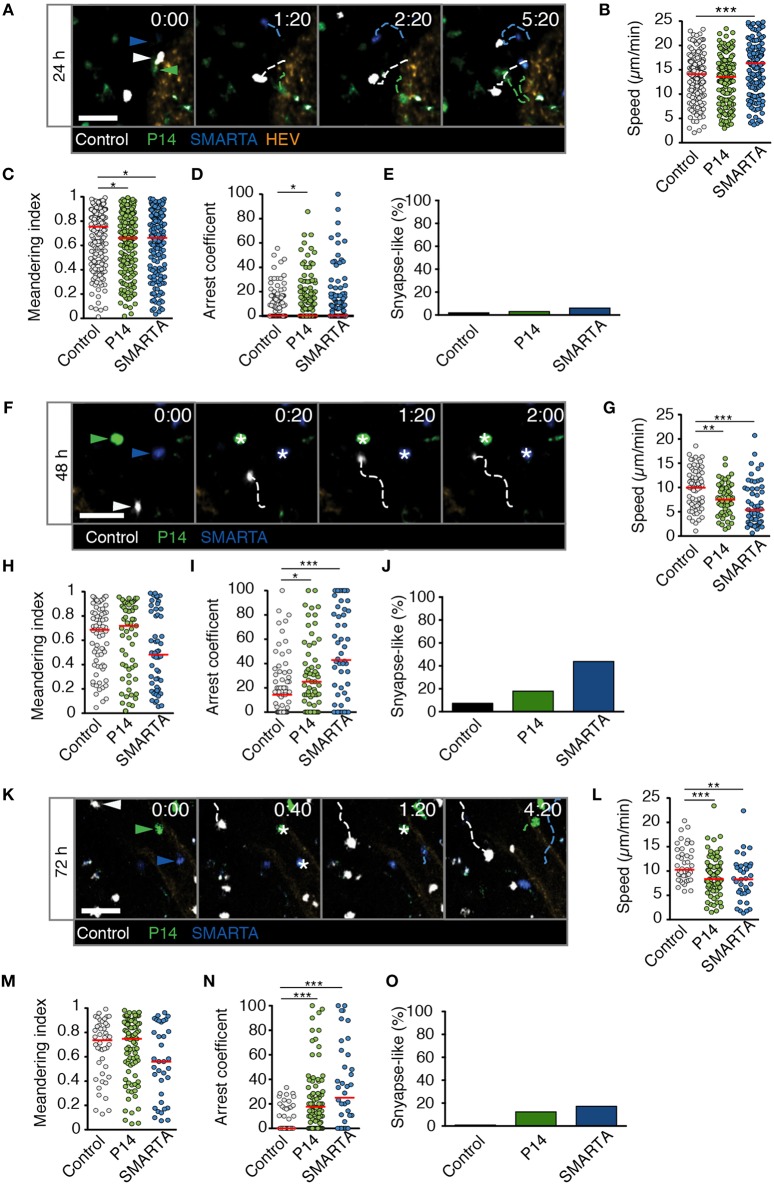
T cell motility in reactive LNs during LD LCMV infection. (A) Representative 2PM images of control (white), P14 (green), and SMARTA T cell tracks (blue) with HEV (orange) at 24 h p.i. Arrowheads point the tracked cell: control (white), P14 (green), and SMARTA (blue). Scale bar, 20 μm. (B–E) Quantification of 2PM motility parameters at 24 h p.i.: Migration speed (B), Meandering index (C), arrest coefficient (D), and percentage of synapse-like T cell motility (E) of control (gray), P14 (green), and SMARTA T cells (blue). (F) Representative 2PM images of control, P14, and SMARTA T cells with HEV (orange) at 48 h p.i. as in (A). Arrowheads point the tracked cell and * indicate arrested T cells. Scale bar, 20 μm. (G–J) Quantification of 2PM motility parameters at 48 h p.i.: Migration speed (G), Meandering index (H), arrest coefficient (I), and percentage of synapse-like T cell motility (J) of control (gray), P14 (green), and SMARTA T cells (blue). (K) Representative 2PM images of control, P14, and SMARTA T cells with HEV at 72 h p.i. as in (A). Arrowheads point the tracked cell and * depict arrested T cells. Scale bar, 20 μm. (L–O) Quantification of 2PM motility parameters at 72 h p.i.: Migration speed (L), Meandering index (M), arrest coefficient (N), and percentage of synapse-like T cell motility (O) of control (gray), P14 (green), and SMARTA T cells (blue). Red lines depict median. Each dot represents a single track. Data are pooled from three independent experiments with a total of four mice (24 h), four mice (48 h), and two mice (72 h). Statistical significance was analyzed by unpaired Mann-Whitney test of control vs. P14 and SMARTA T cells, respectively. *p < 0.05; **p < 0.01; ***p < 0.001.